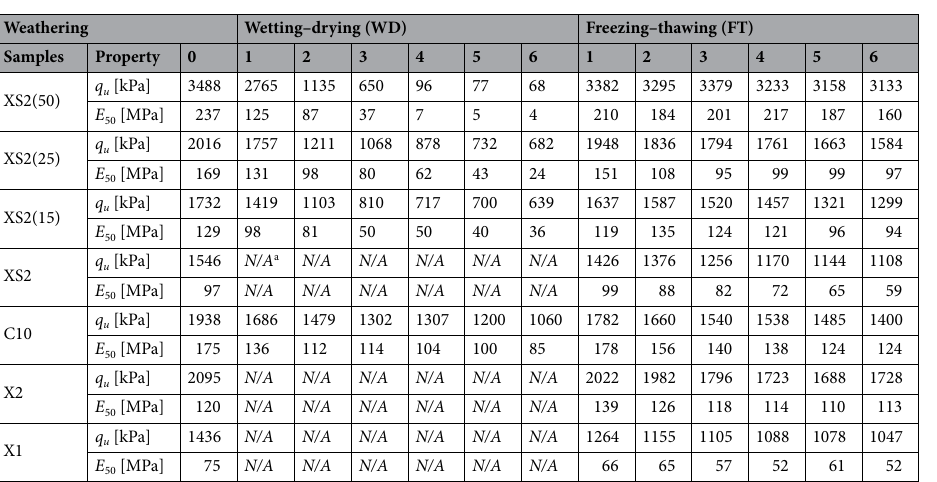
Table 3. Strength and stiffness of stabilized soils before and after weathering cycle. a N/A denotes ‘not available’ due to collapse of